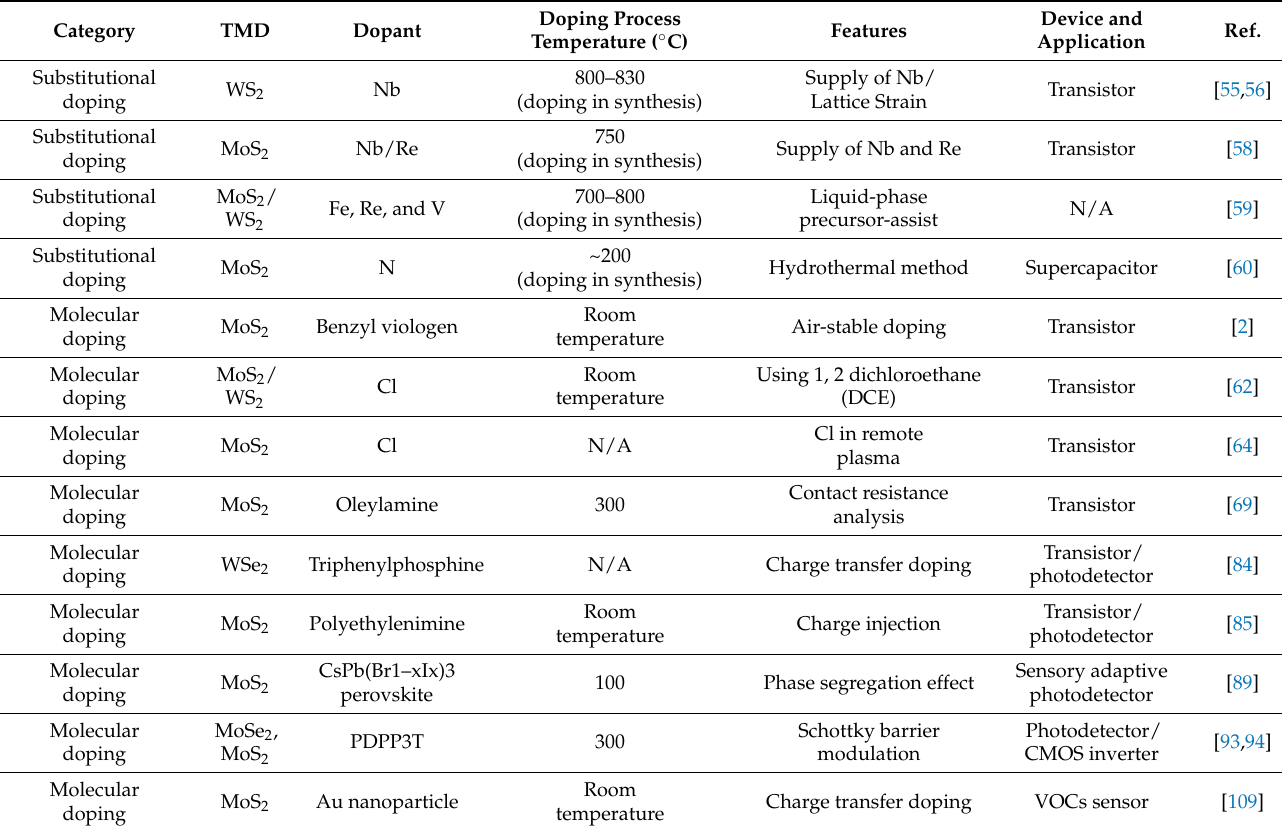
Table 1. Comparison among TMD doping techniques with respect to doping process temperature, features, and applications. Category TMD Dopant